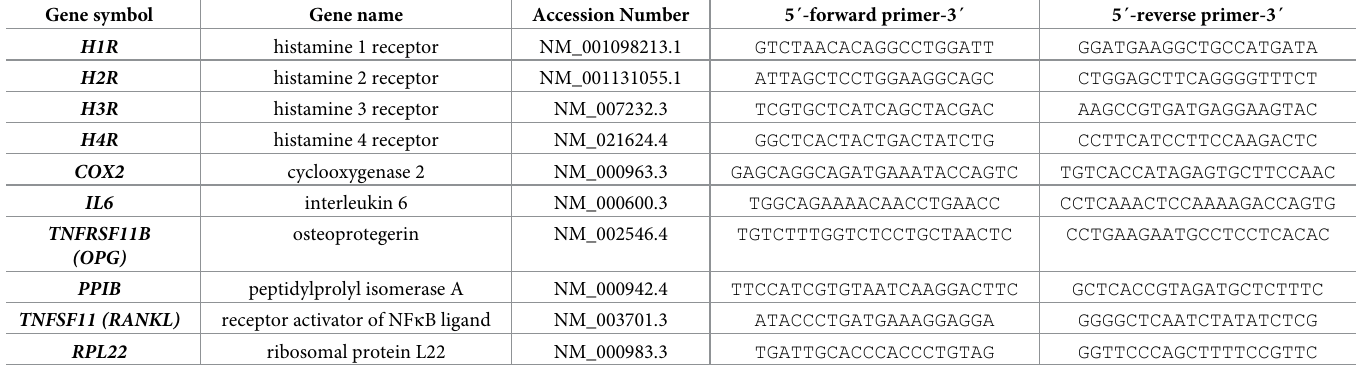
Table 1. Primer data for target genes and reference genes ( PPIB , RPL22 ) for semiquantitative and RT-qPCR. Gene